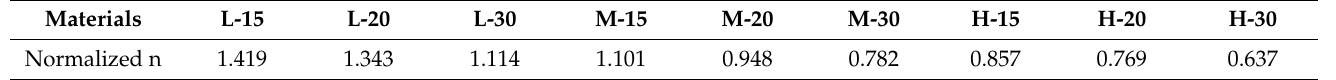
Table 4. The normalized strain hardening components n of composites.